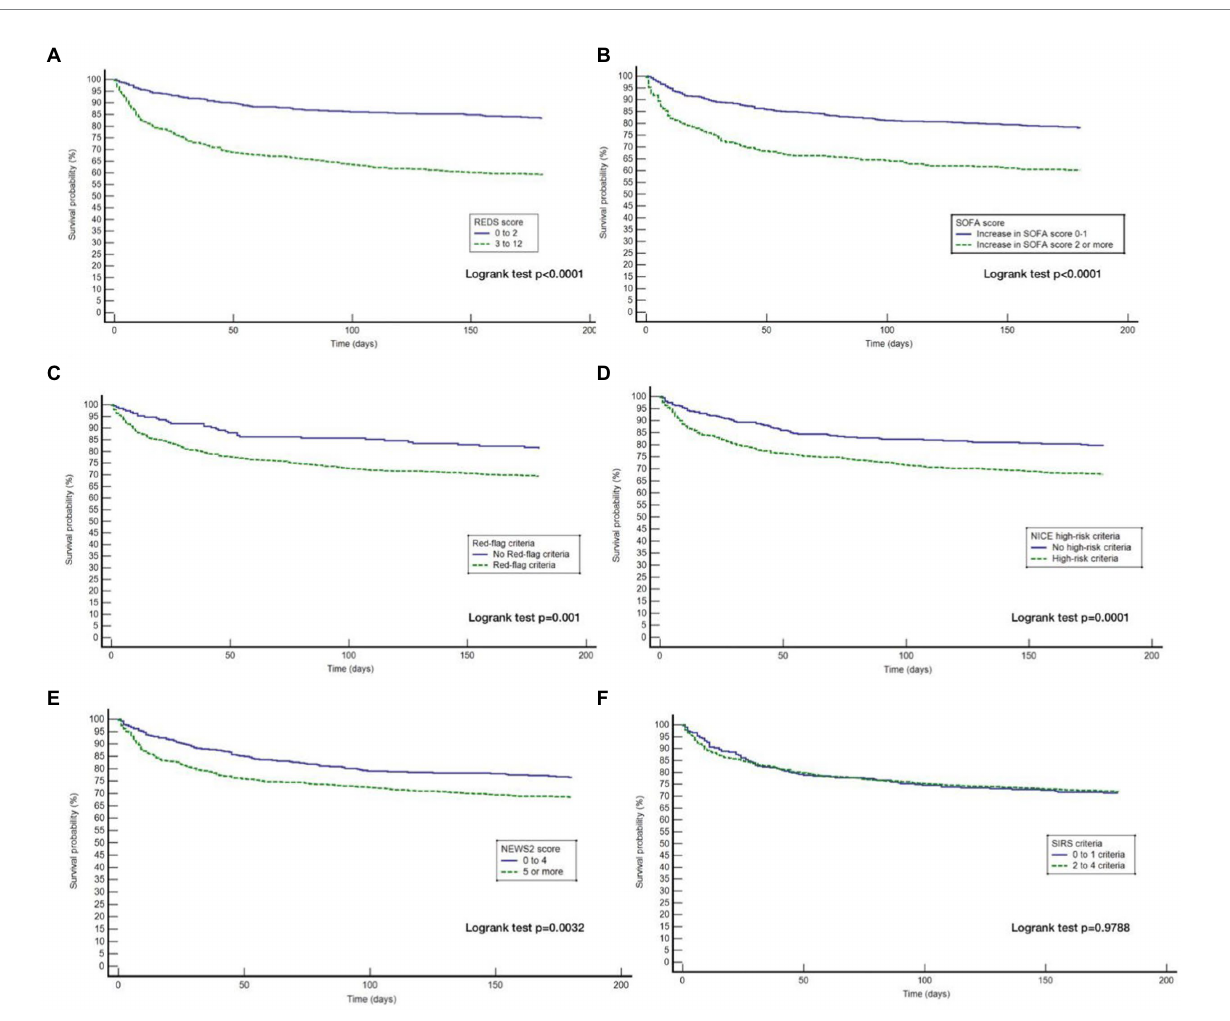
scores, for in-hospital mortality (Table 4). The results were similar for mortality at 180 days, except for the difference in the AUROC curve